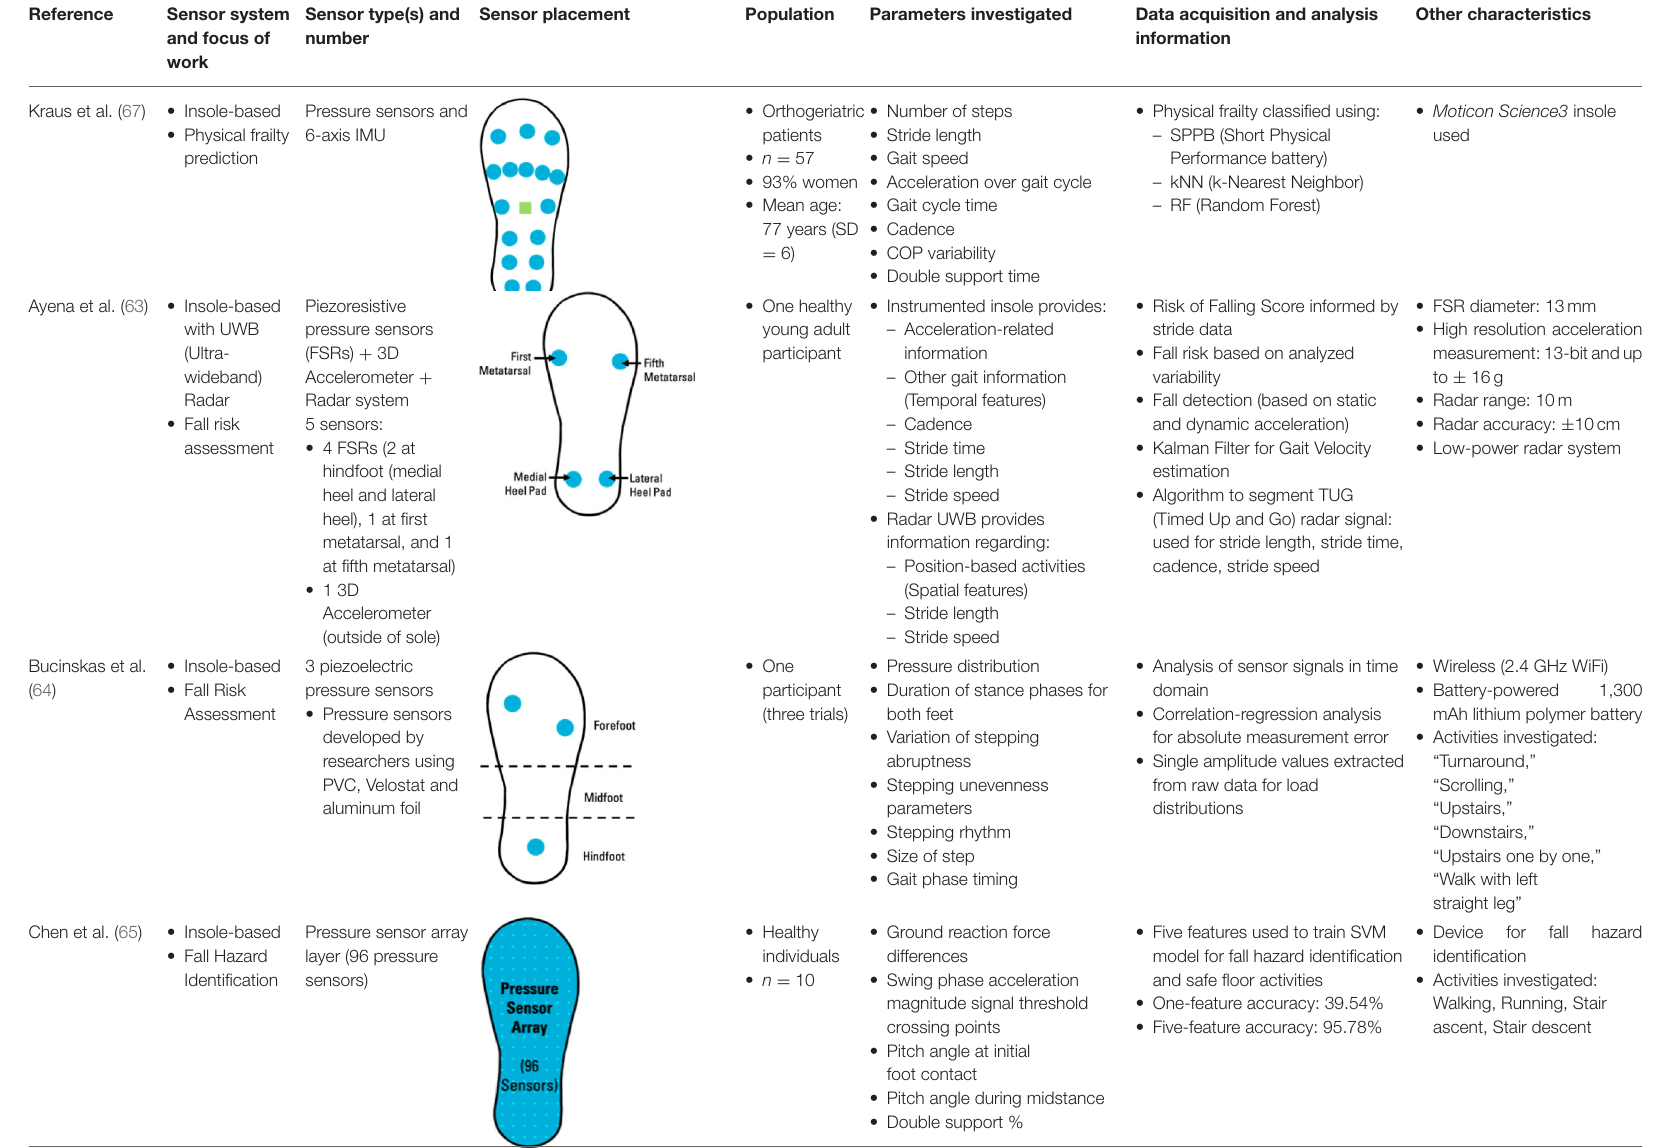
TABLE 2 | Key points pertaining to insole-based systems used for fall risk assessment and fall detection.